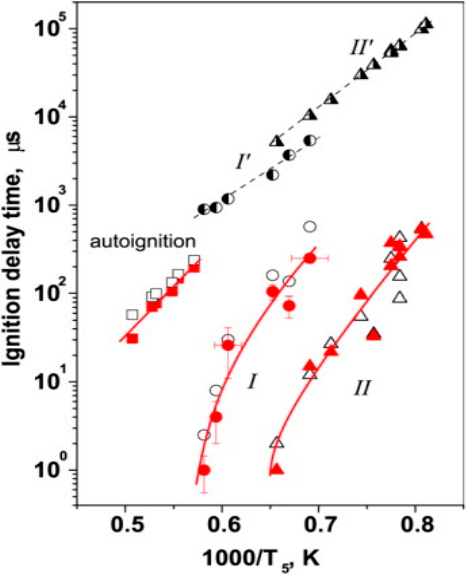
Figure 2. The ignition delay time in a CH 4 :O 2 :Ar = 3.3:6.7:90 mixture as a function of temperature for (I’–II’) auto-ignition and (I–II) ignition with the electric discharge. The closed symbols correspond to measurements and the open symbols correspond to calculations [3]. Reprinted from [3] with permission from Elsevier.